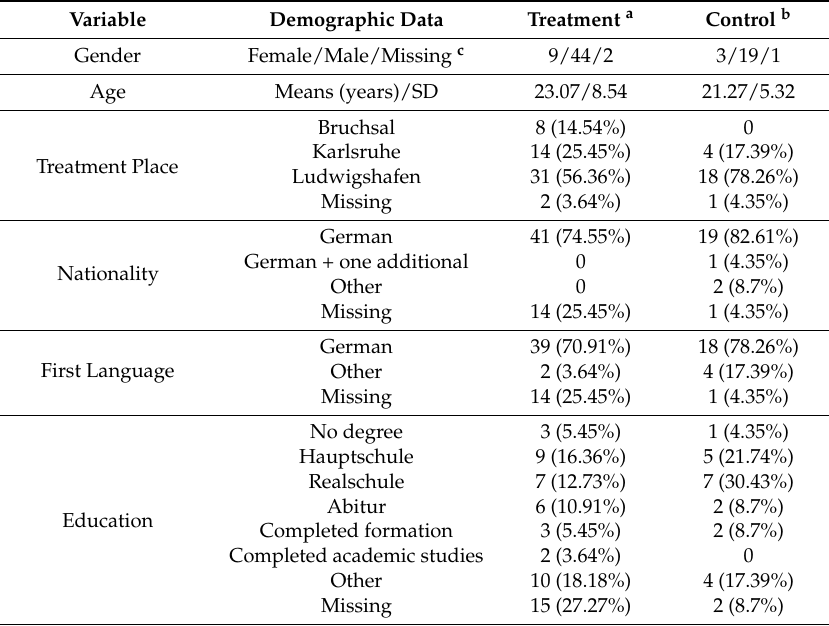
Table 1. Demographic data of the study